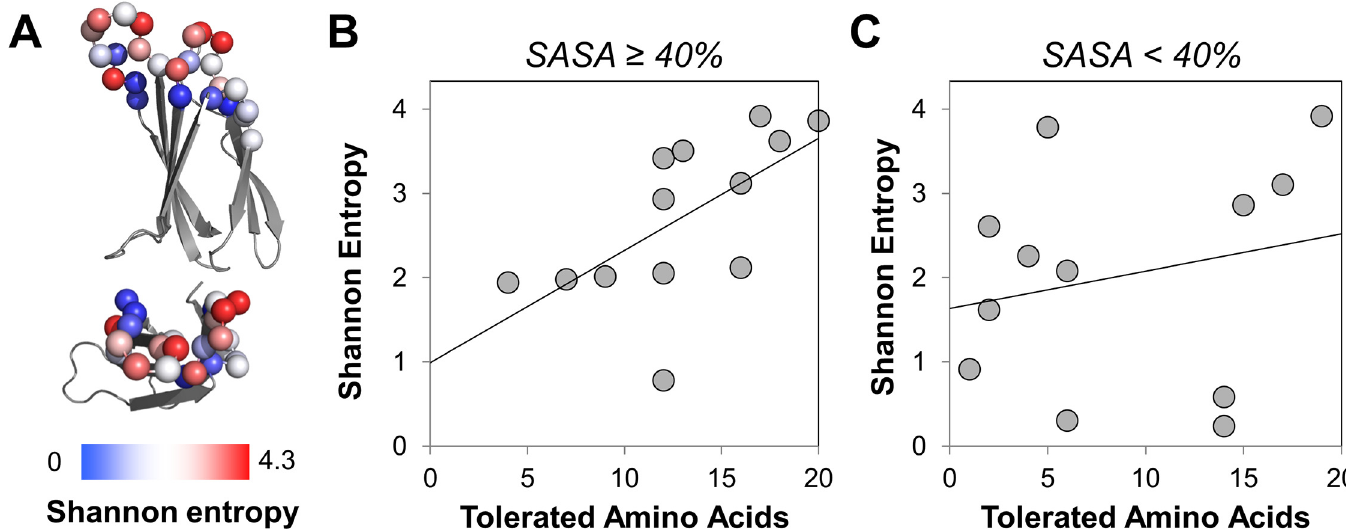
Fig 7. Shannon entropy landscape among binding population. (A) The α carbons of evaluated sites are shown in spheres colored based on Shannon entropy of binding sequences from the second generation campaigns. (B, C) The Shannon entropies at each site of second generation binders are plotted versus the number of amino acids that are tolerated at that site based on computational stability predictions. (B) Sites with solvent accessible surface area (in other fibronectin domain mutants) (cid:3) 40%. Pearson coefficient = 0.63. Slope = 0.13. (C) Sites with solvent accessible surface area < 40%. Pearson coefficient = 0.22. Slope =